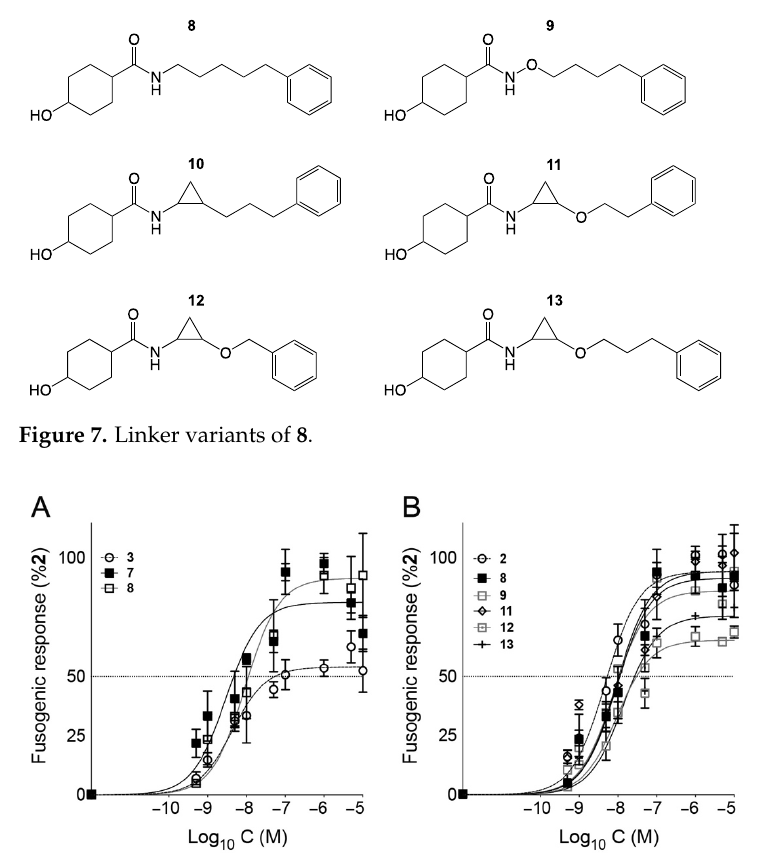
Figure 8. Fusogenicity dose response curves for compounds reported in Tables 3 and 4. ( A ) 3 , 7 , and 8 from Table 3. ( B) 2 , 8 , 9 , 11 , 12 , and 13 from Table 4. 8 is duplicated for comparison.